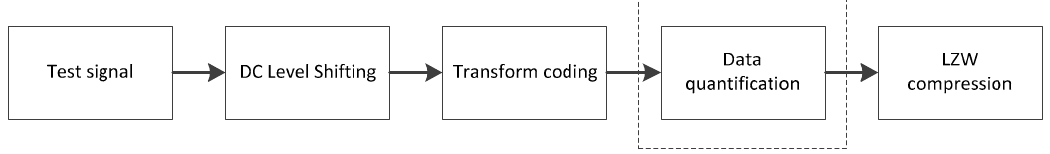
Figure 6. The block diagram of a compression system.